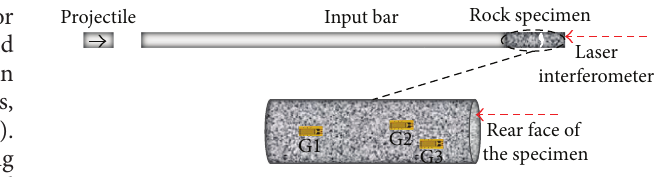
Figure 1: Spalling experiment setup with Hopkinson